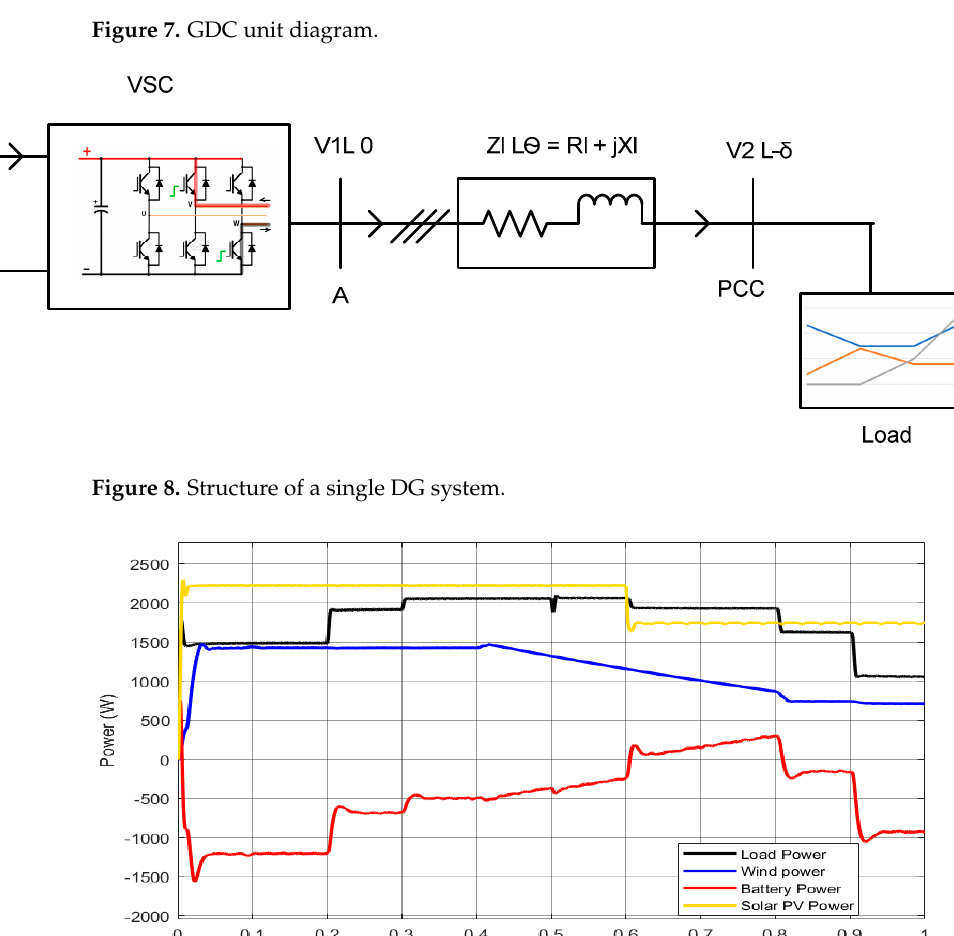
Figure 9. Load vs. Source power.